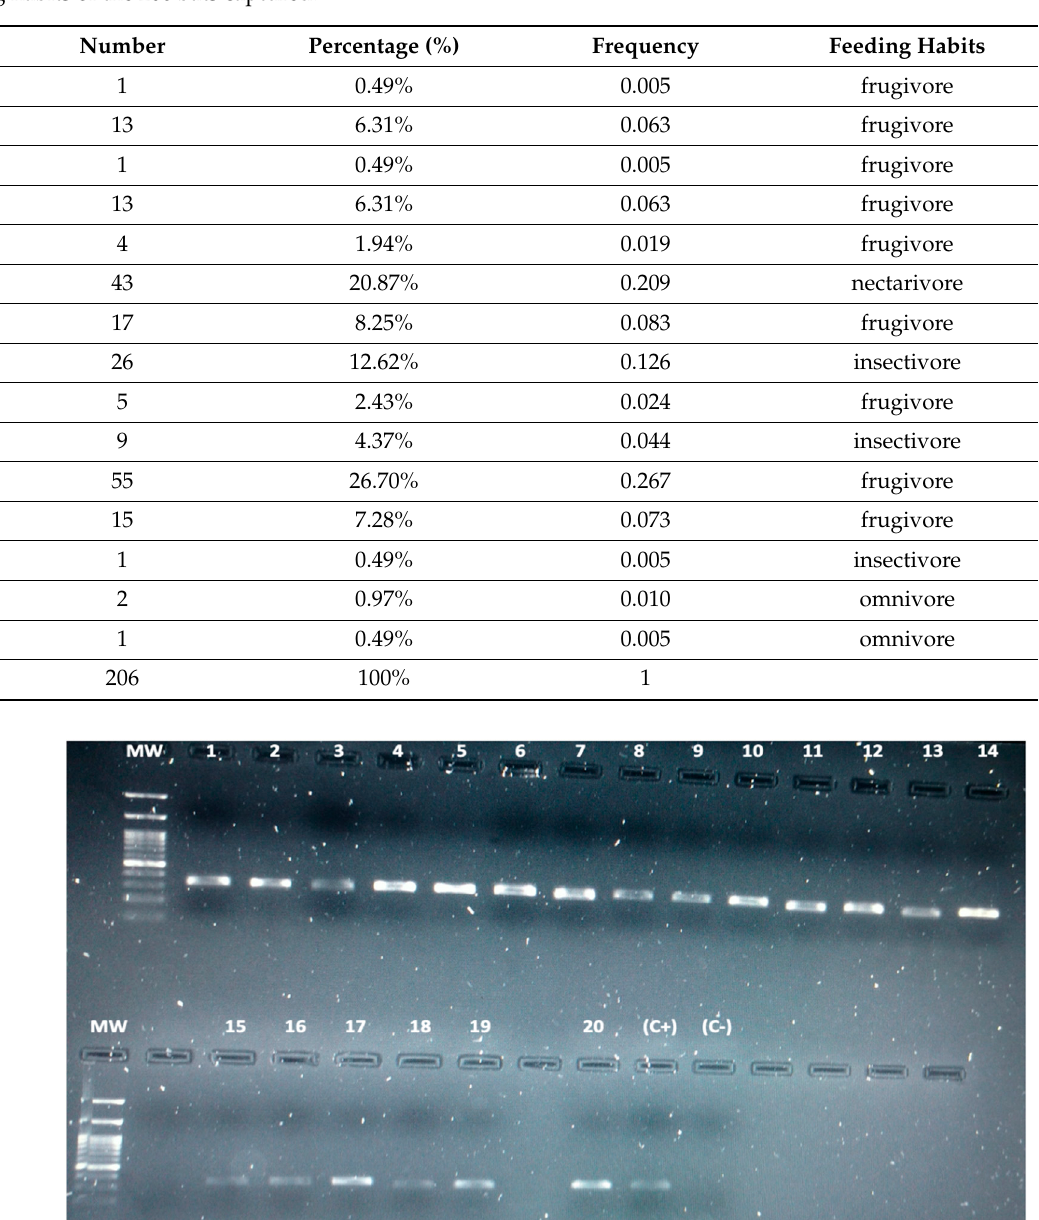
Table 1. Diversity of bats captured in the study. This table shows information about the species, number, percentage, frequency and feeding habits of the 206 bats captured.